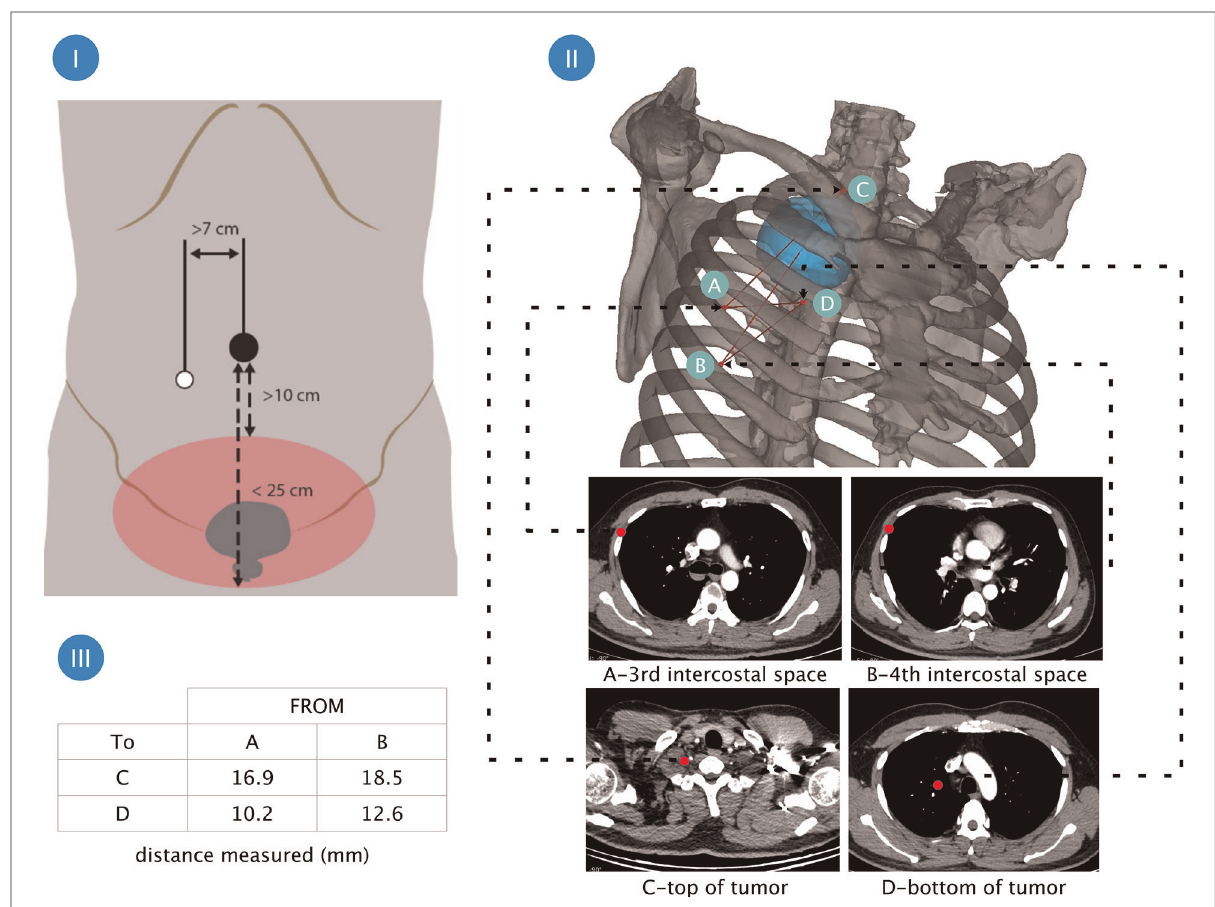
FIGURE 3 Planning the surgical incision and simulation of the workspace through preoperative 3D reconstruction ensured the surgical area be covered. Part I: According to the instructions, the cannula should be positioned at a distance from the operating area 10 cm – 25 cm; Part 2: 3D reconstruction using OsiriX software (Fondation OsiriX, Geneva, Switzerland) and measurement of the distance between the 3rd and 4th intercostal spaces to the uppermost and lowermost Poles of the tumor. Part III:display of measurement